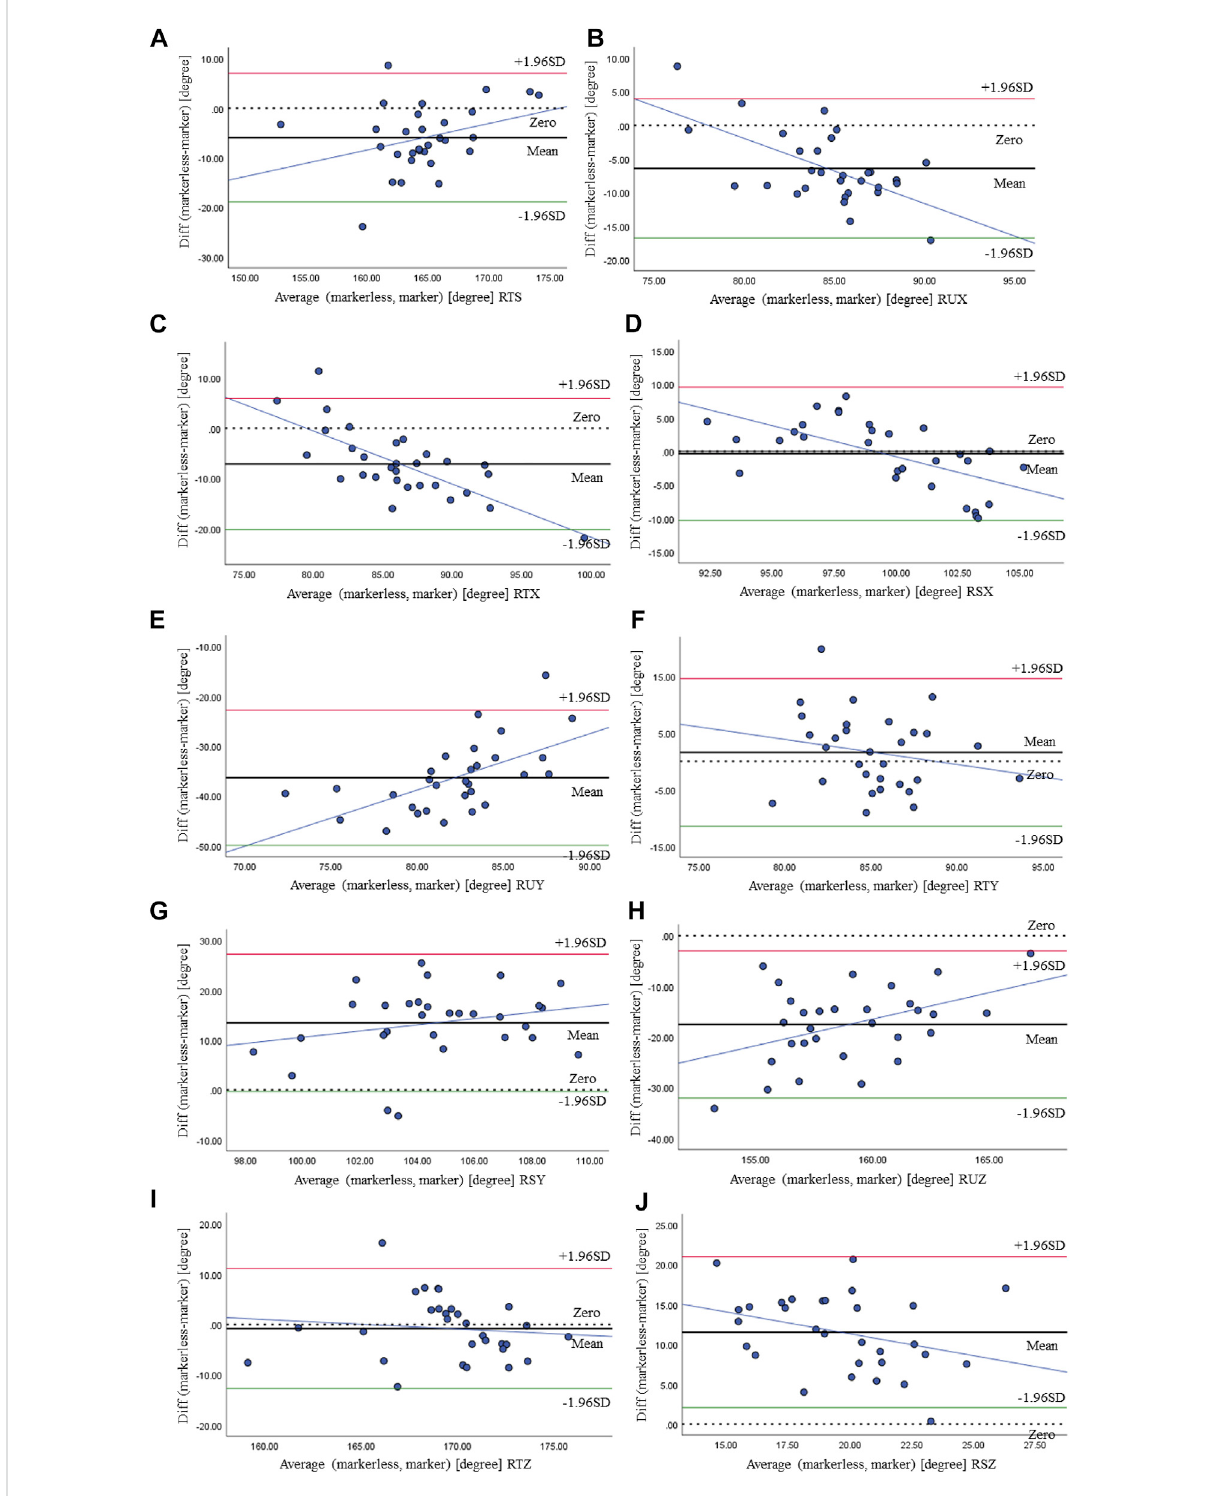
FIGURE 5 Bland – Altman plot of RTS (A) , RUX (B) , RTX (C) , RSX (D) , RUY (E) , RTY (F) , RSY (G) , RUZ (H) , RTZ (I) , and RSZ (J) at maximum fl exion and comparison between the markerless- and marker-based